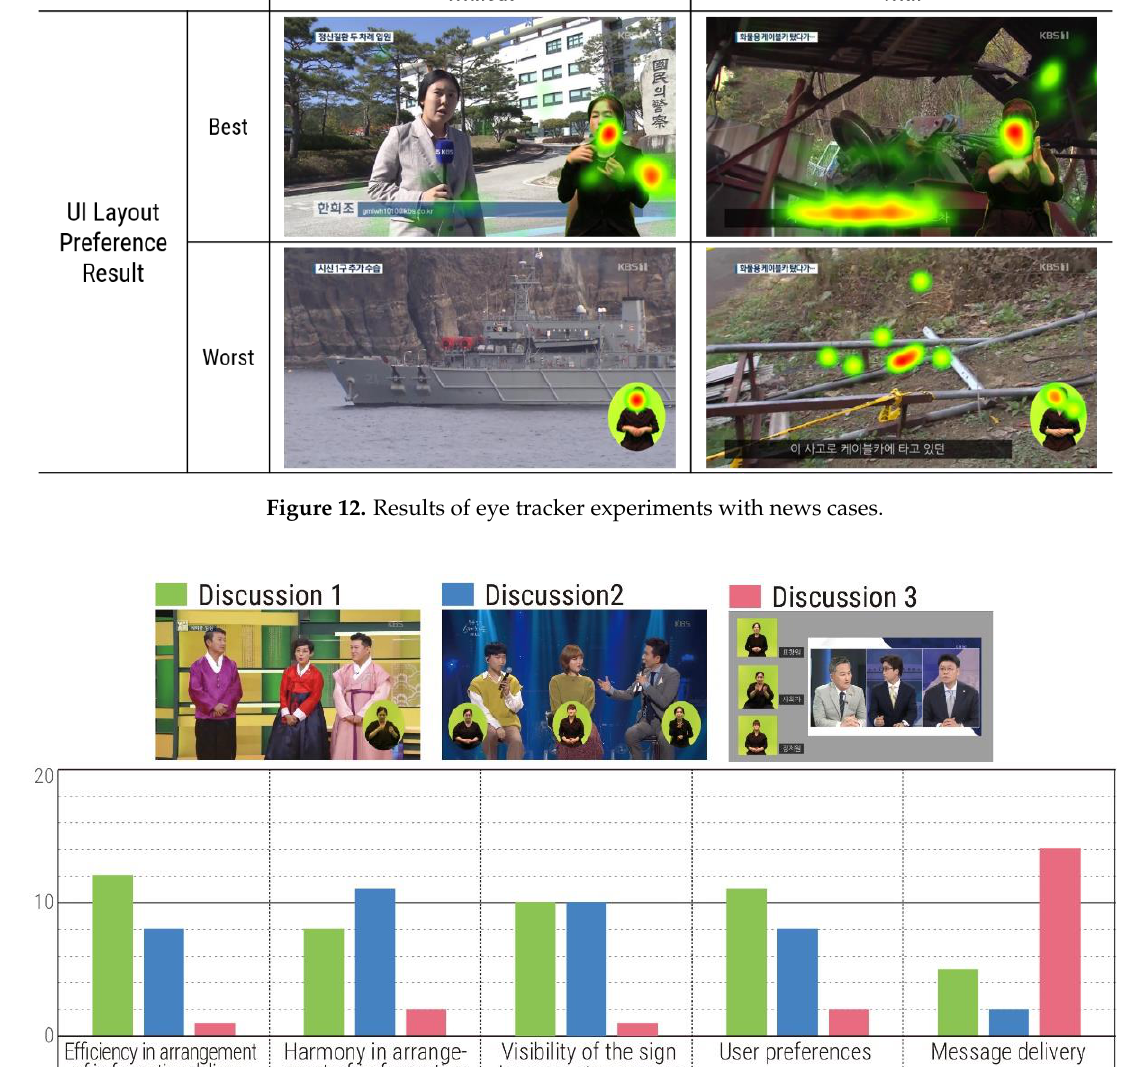
Figure 12. Results of eye tracker experiments with news cases.